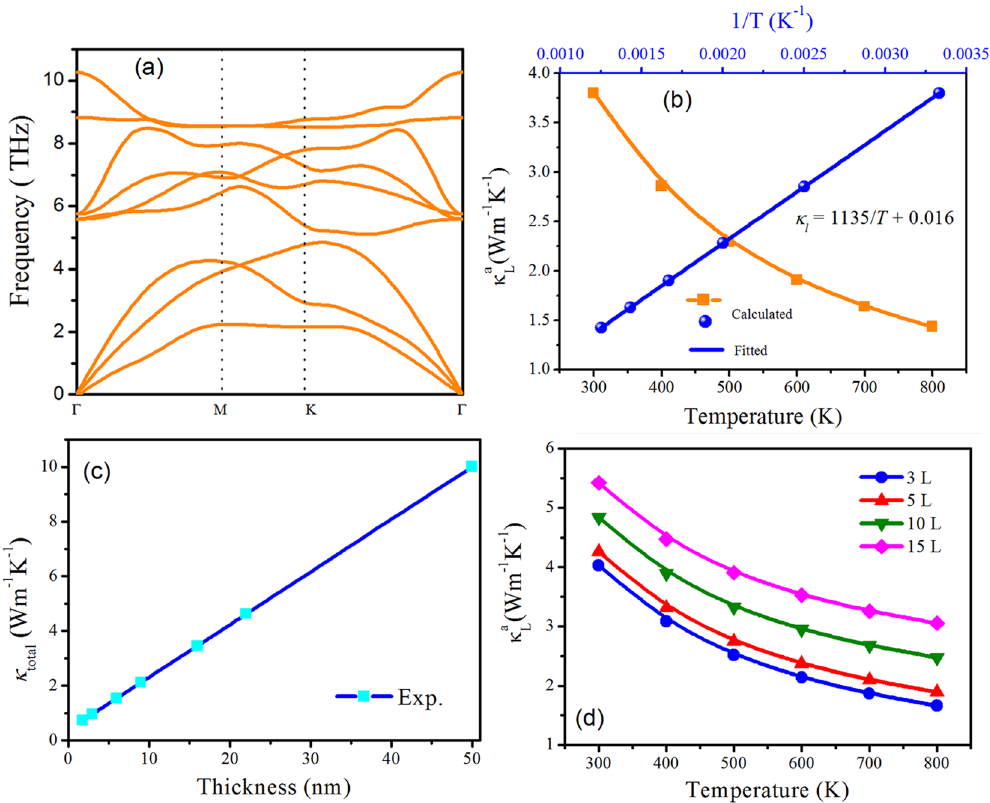
Figure 4. Phonon dispersions along high symmetry of monolayer SnS 2 ( a ). Calculated lattice thermal conductivity of monolayer SnS 2 as a function of temperature. ( b ) The fitted lattice thermal conductivity according to experimental reports as a function of thickness ( c ). Simulated lattice thermal conductivity of SnS 2 nanosheets for various layers as a function of temperature ( d ).